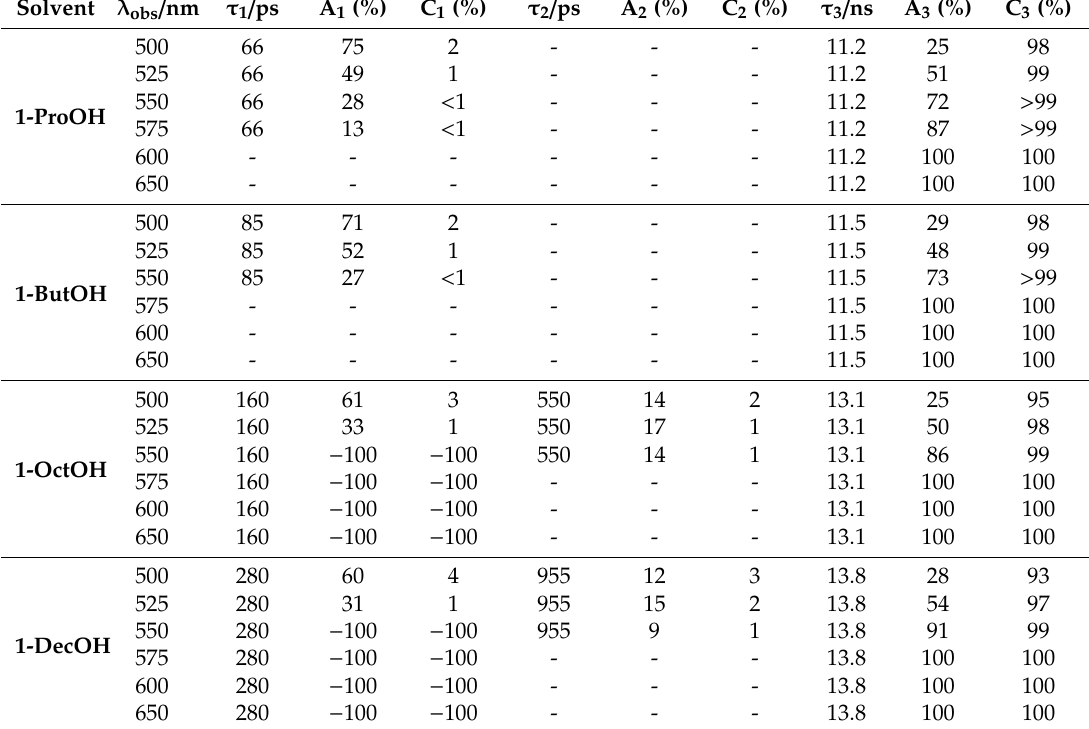
Table 2. Time constant τ i, normalized (to 100), pre-exponential factor Ai and fractional contributions (Ci = τ iAi) extracted from the fit of the emission decays of Me 2 CANADC in 1-ProOH, 1-ButOH, 1-OctOH, and 1-DeOH upon excitation at 390 nm. The estimated error is about